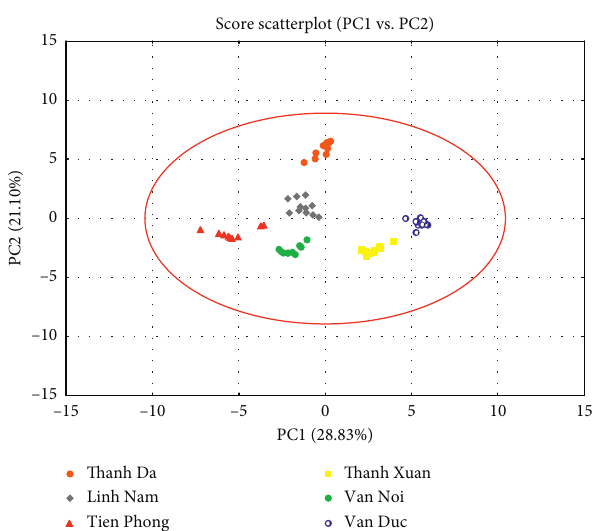
Figure 3: PCA scores scatterplot of principal components 1 and